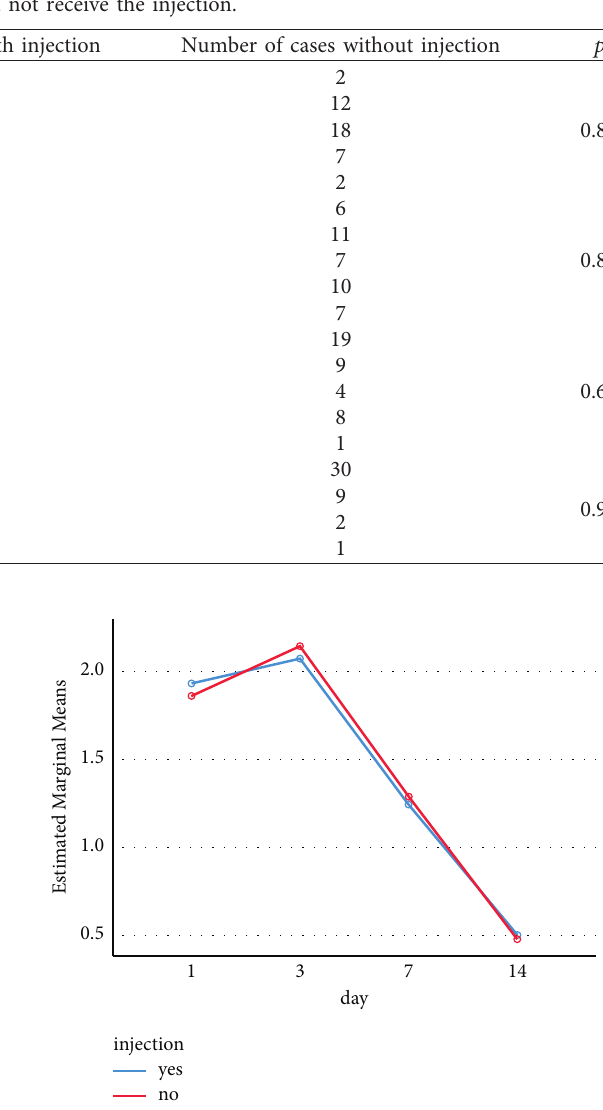
Figure 2: The reduction of edema on days 1, 3, 7, and 14 based on having or not having an injection. According to the graph, the reduction of right edema after 14 days was statistically significant in both groups ( p < 0 . 001). But no significant difference was observed between the groups ( p � 0 .